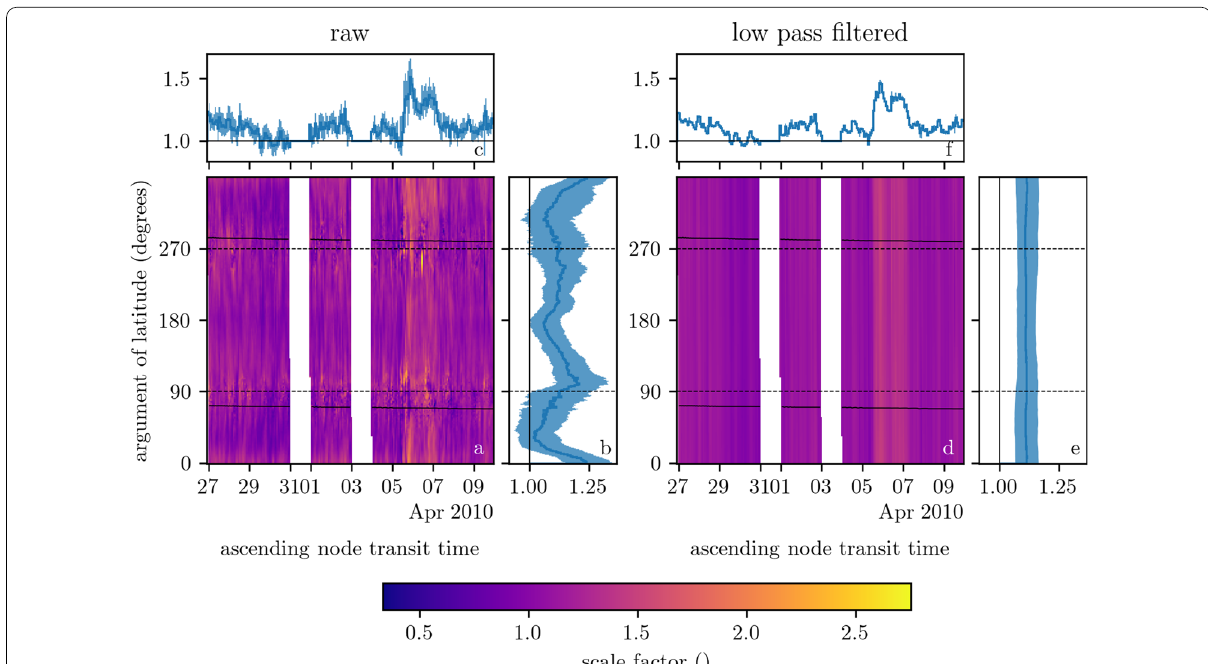
Fig. 3 Panel a shows the scale factor between the neutral densities computed with NRLMSIS 2.0 and the neutral densities derived from the CHAMP accelerometer. The argument of latitude is the angle–measured on the orbital plane–between the ascending node and the satellite. Values of 0 ◦ and 180 ◦ correspond to the night side and day side equator, respectively. At 90 ◦ and 270 ◦ CHAMP is closest the north and south pole, respectively. The solid black line is the border between day and night side. The dashed black line marks the point where the satellite is closest to the poles. The solid blue line in panel b is the median scale factor at the corresponding argument of latitude. The solid blue line in panel c is the median scale factor at the corresponding orbit. The light blue areas in panels b and c mark the interval between the 25th and 75th percentile. Panels d, e, f show the scale factors filtered with a 3-hourly low-pass filter analogously to panels a, b,